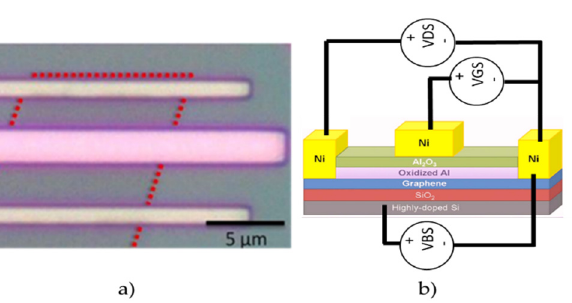
Figure 4. Top/back gated transistors: ( a ) GFET fabricated in [38]; and ( b ) its architecture.